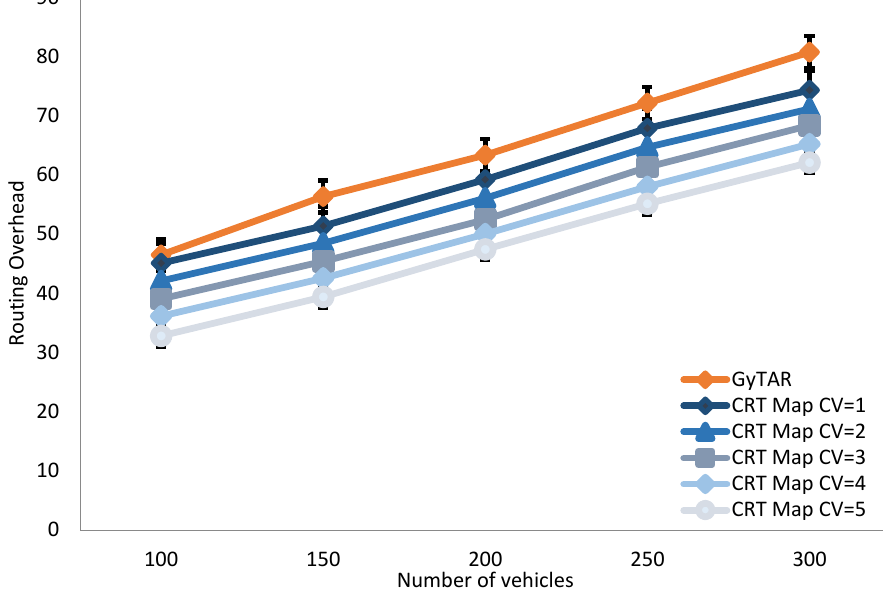
Figure 14. Routing Overhead (per route) vs. Number of vehicles.